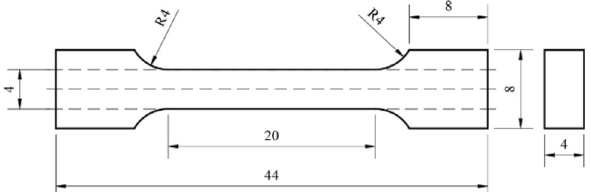
Fig. 1 Sample shapes and dimensions for tensile tests of WE43 magnesium alloy EBW joint and base metal (unit: mm)